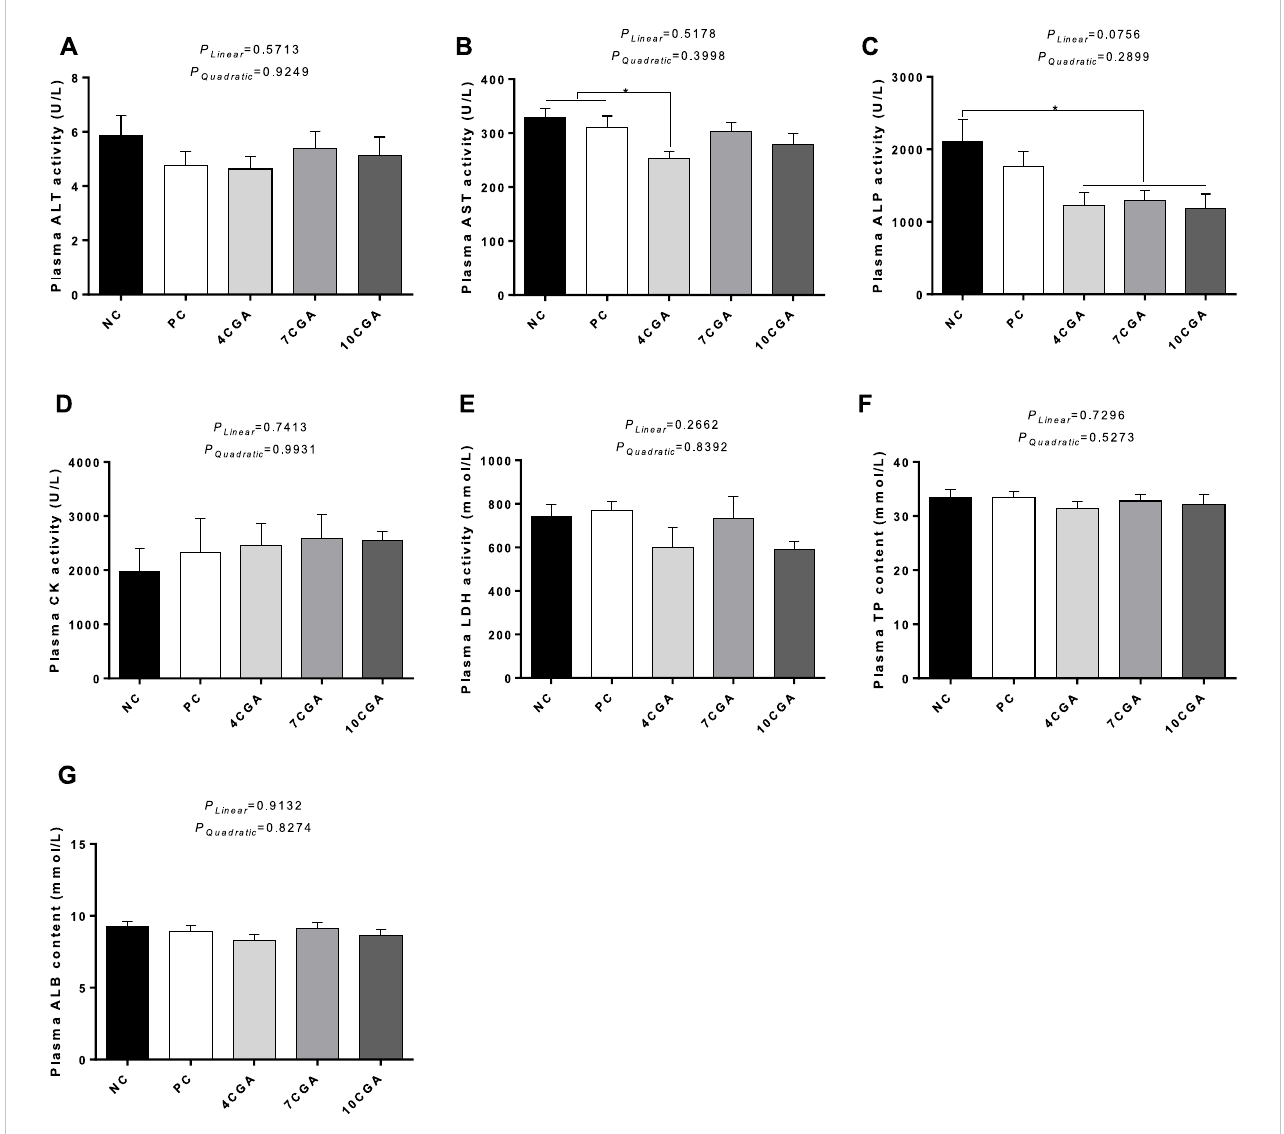
FIGURE 2 Effects ofinovo feeding ofchlorogenic acid on plasmabiochemical parametersof 42 d-heatstressedbroilers. (A) ALT; (B) AST; (C) ALP; (D) CK; (E) LDH; (F) TP; (G) ALB. * indicates a signi fi cant difference between treatments ( p < 0.05), n = 6.